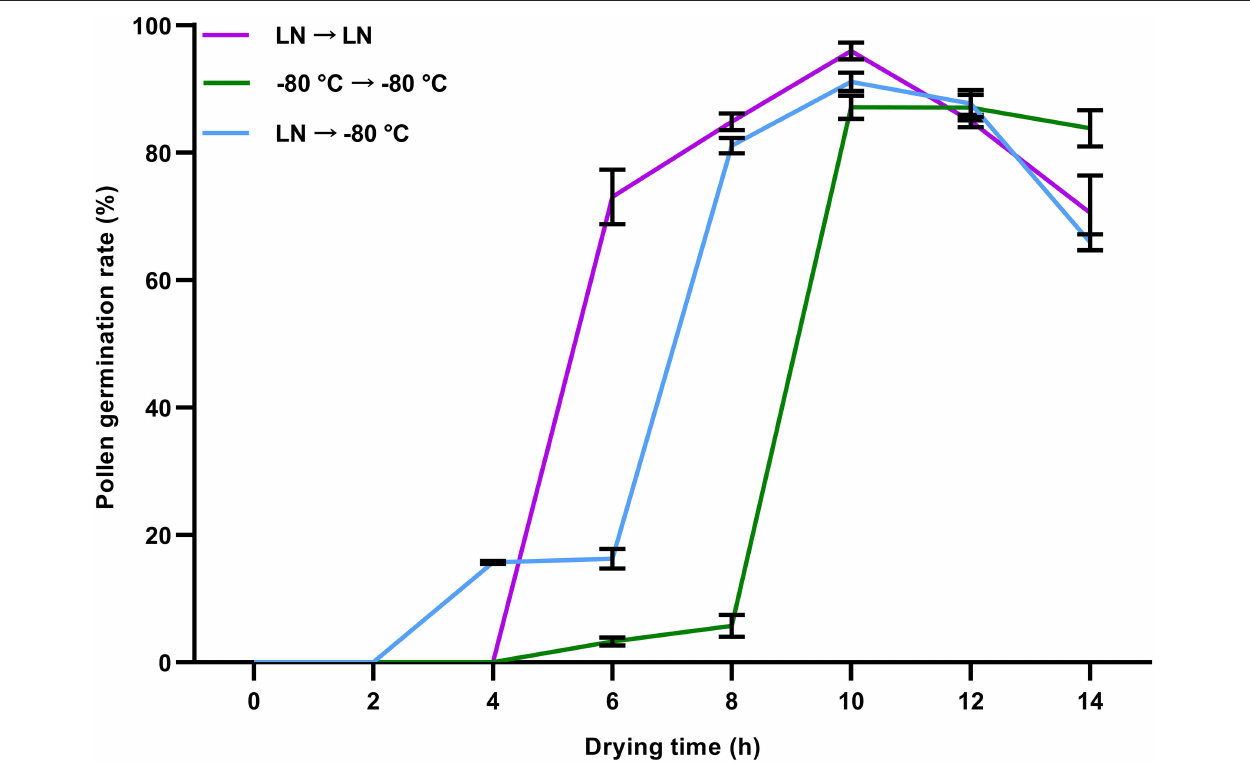
FIGURE 5 | Germination rates of soybean pollen after different freezing and preservation treatments. LN → − 80 ◦ C, flowers were frozen in liquid nitrogen (LN) for 72h and then stored in a − 80 ◦ C freezer; − 80 ◦ C → − 80 ◦ C, flowers were frozen and preserved in a − 80 ◦ C freezer; LN → LN, flowers were frozen and preserved in LN. The flowers at the initially-open stage were collected and dehydrated in a drying oven at different times. After preservation, the flowers were thawed at room temperature for germination tests. All data were represented as mean ± SD of three replicates.